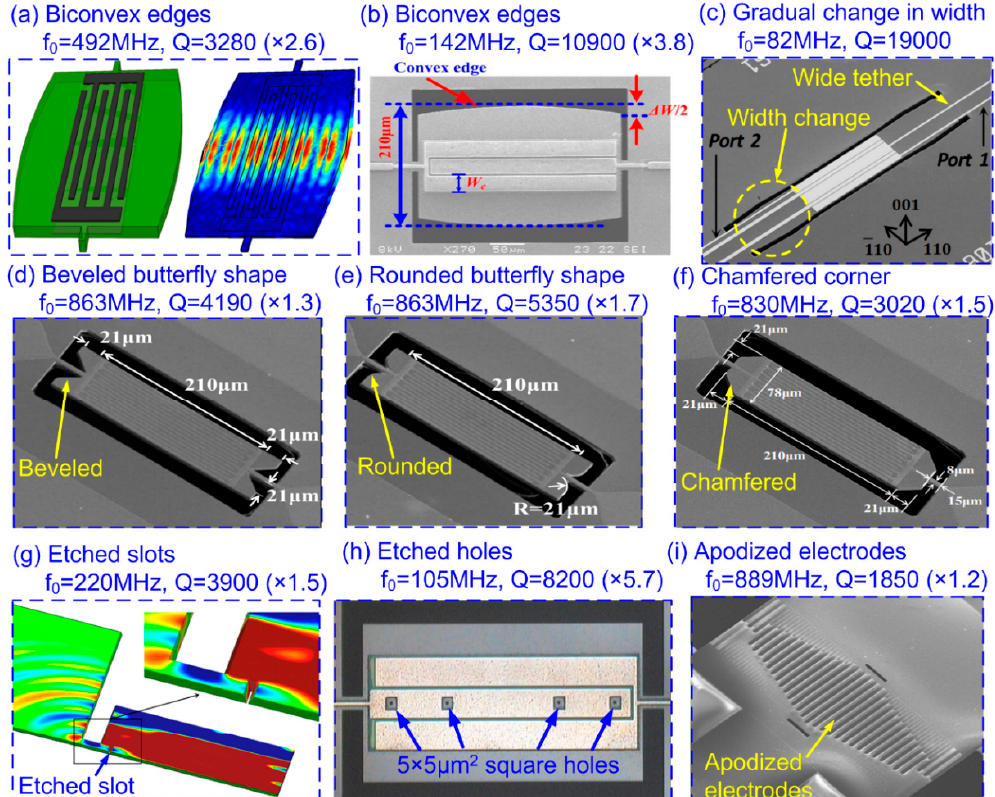
Figure 8. Q-enhancement strategies by geometry modification on the resonator body: ( a ) schematic and simulated mode shape of a 492-MHz AlN LVR using biconvex edges. This figure is reproduced from [109] ( © 2011 AIP Publishing); ( b ) SEM of a 142-MHz AlN-on-Si LVR using biconvex edges. This figure is reproduced from [111] ( © 2018 IOP Publishing); ( c ) SEM of a 82-MHz AlN-on-Si LVR using gradually-changed width. This figure is reproduced from [113] ( © 2019 IEEE); ( d ) SEM of a 863-MHz AlN LVR with beveled butterfly shape; ( e ) SEM of a 863-MHz AlN LVR with rounded butterfly shape. ( d , e ) are reproduced from [115] ( © 2017 IEEE); ( f ) SEM of a 830-MHz AlN LVR with chamfered corners. This figure is reproduced from [117] ( © 2015 IEEE); ( g ) simulated vibration mode shape of a 220-MHz AlN LVR with etched slot. This figure is reproduced from [118] ( © 2013 IEEE); ( h ) optical micrograph of a 105-MHz AlN-on-Si LVR with etched holes. This figure is reproduced from [119] ( © 2017 Elsevier); ( i ) SEM of a 889-MHz AlN LVR using apodized electrode configuration. This figure is reproduced from [120] ( © 2014